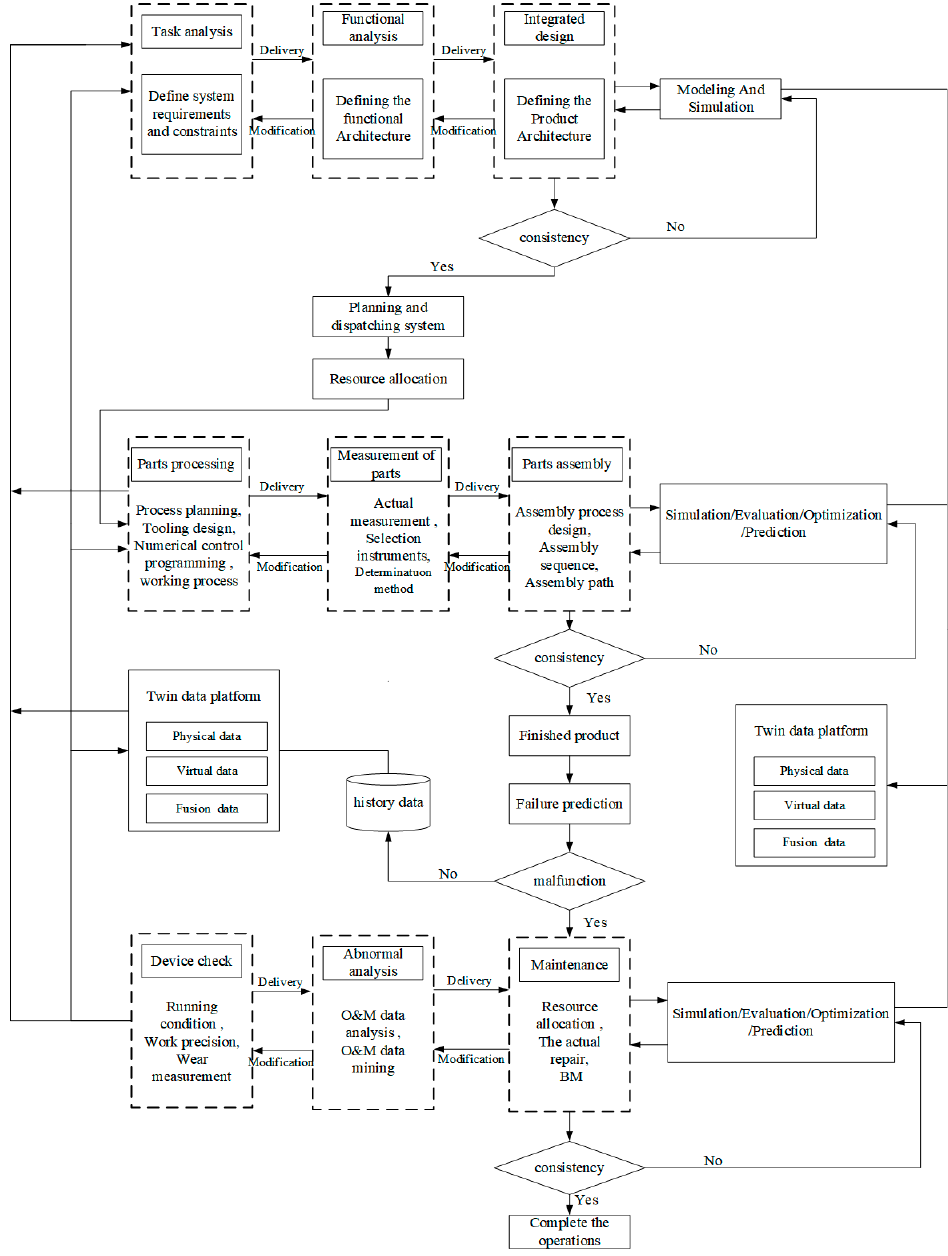
Figure 3. Design, manufacturing, O&M integrated operation mechanism driven by digital twin.